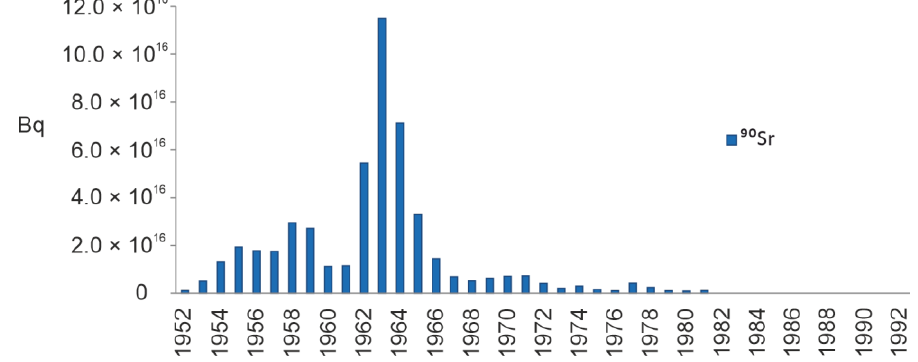
Figure 17. Annual Northern hemispheric 90 Sr fallouts (calculated) [87].